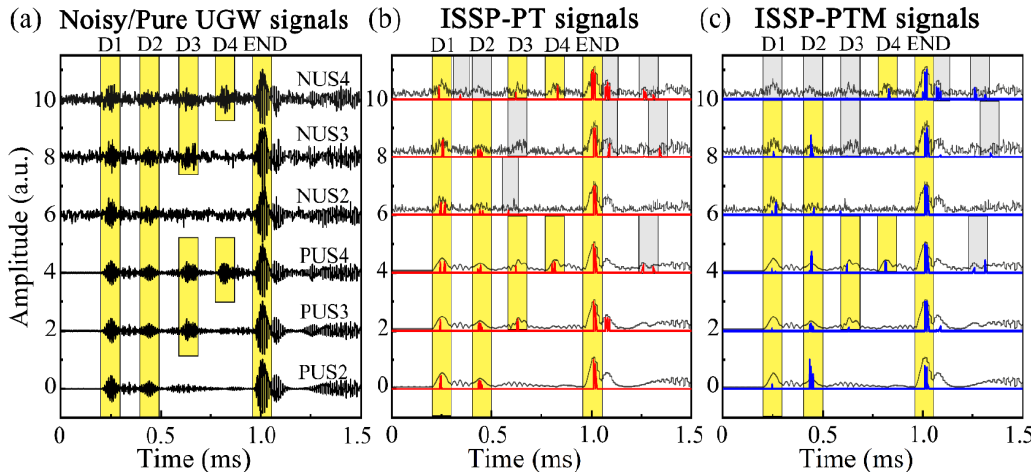
Figure 8. ( a ) Pure and noisy UGW signals, sparse signals processed by ( b ) ISSP-PT and ( c ) ISSP-PTM.